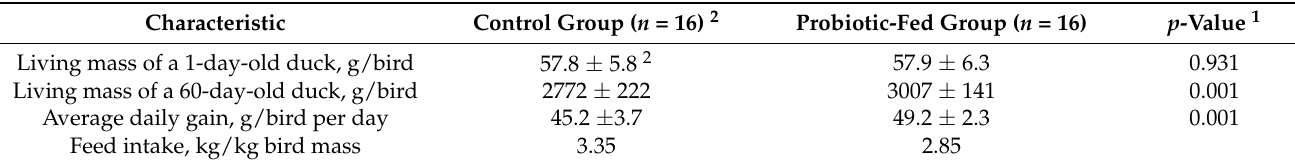
Table 4. Production characteristics of ducks fed with conventional (control) and probiotic-supplemented feed (probiotic- fed